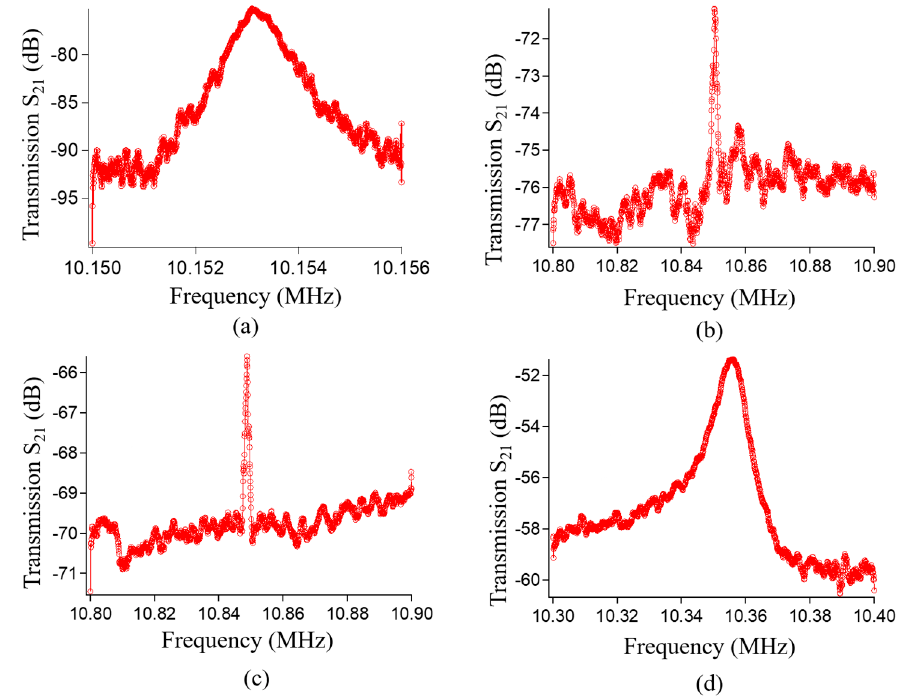
Figure 6. Frequency responses. ( a ) First mode vibration structure; ( b ) second mode vibration structure; ( c ) third mode vibration structure; ( d ) fourth mode vibration structure.